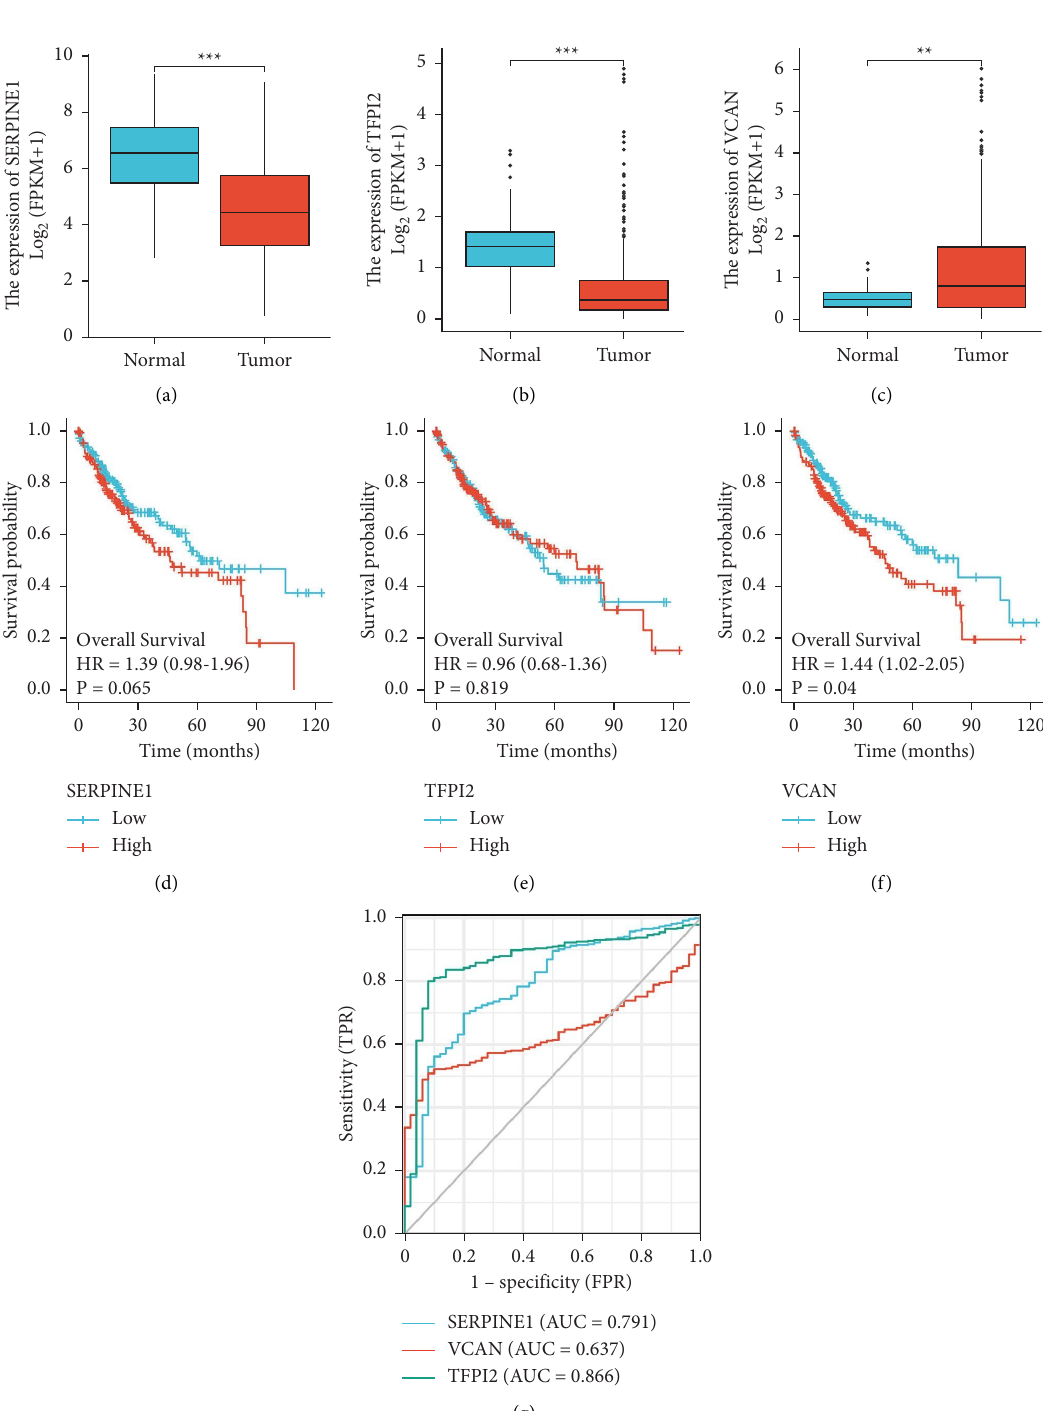
Figure 5: (a) Boxplots showing the diferential expression of SERPINE1 in tumor patients and the normal population. (b) Boxplots showing the diferential expression of TFPI2 in tumor patients and normal population. (c) Boxplots showing the diferential expression of VCAN in tumor patients and the normal population. (d) Te survival analysis demonstrated the low- and high-expression groups of SERPINE1. (e) Te survival analysis demonstrated the low- and high-expression groups of TFPI2. (f) Te survival analysis demonstrated the low- and high- expression groups of VCAN. (g) Te ROC curve demonstrates the predictive value of SERPINE1, TFPI2, and